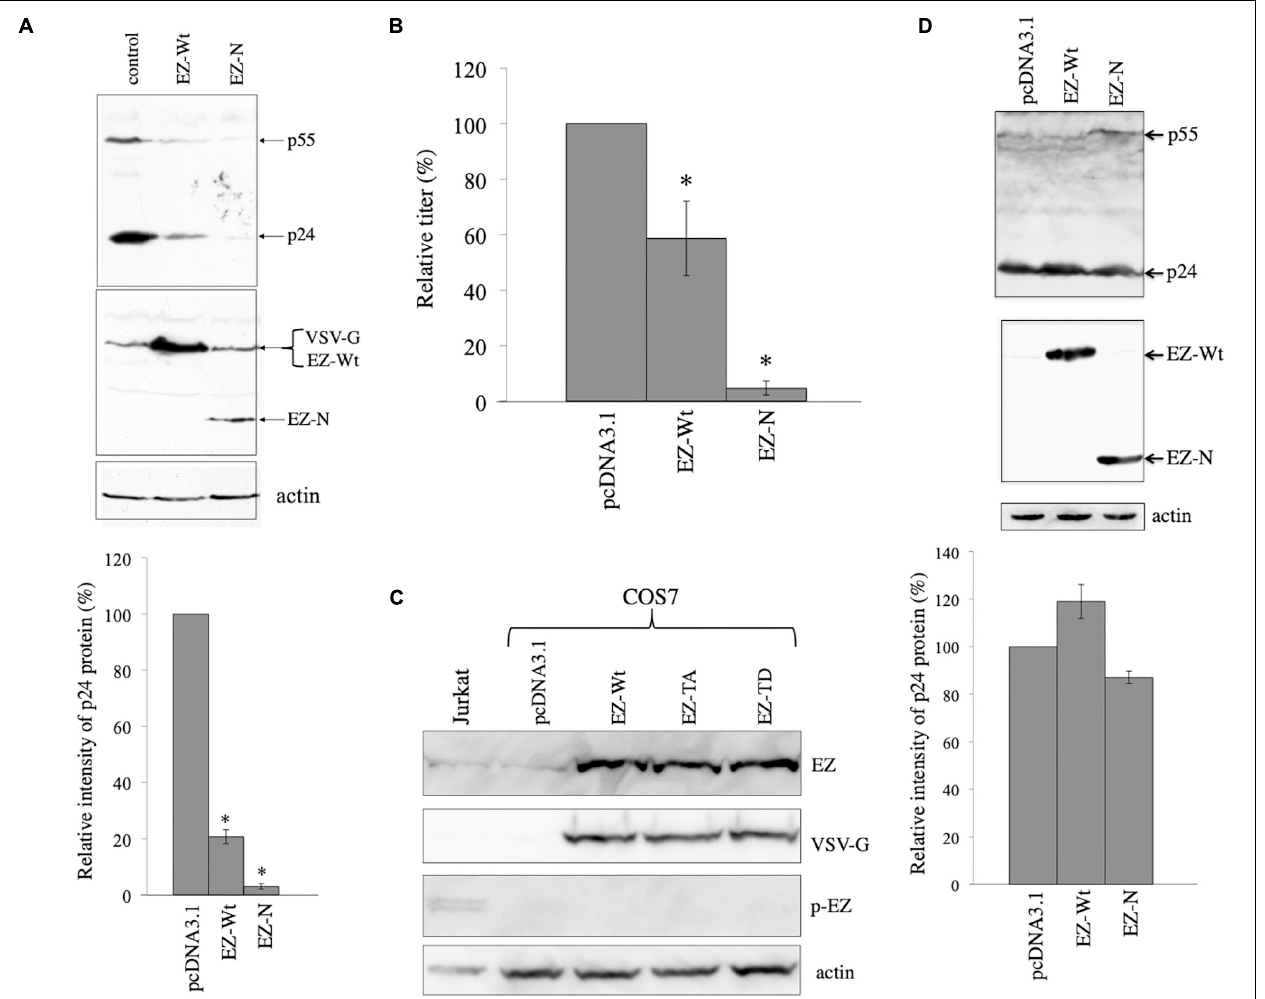
FIGURE 4 | Ezrin is involved in the VSV-G-mediated stabilization of HIV-1 Gag protein. (A) COS7 cells were transfected with the VSV-G-pseudotyped HIV-1 vector construction plasmids together with pcDNA3.1 (control), VSV-G-tagged ezrin wild type (EZ-Wt), or VSV-G-tagged ezrin dominant negative mutant (EZ-N) expression plasmid. Cell lysates from the transfected cells were analyzed by western immunoblotting (upper panel). HIV-1 Gag precursor (p55), mature capsid (p24), EZ-Wt, EZ-N, and VSV-G proteins were indicated by arrows. Ez-Wt and VSV-G were not separated. Intensities of the HIV-1 p24 protein bands were measured by a densitometer. Relative values to the intensities in the pcDNA3.1-transfected cells are indicated (lower panel, n = 3). Asterisks show significant differences compared to pcDNA3.1. (B) Culture supernatants from the transfected cells were inoculated into HeLa cells, and transduction titers were counted. Transduction titers in the pcDNA3.1-transfected cells were always set to 100. Relative values to the titers in the pcDNA3.1-transfected cells are indicated. This experiment was repeated three times, and means ± standard deviations are indicated. Asterisks show significant differences compared to pcDNA3.1. (C) COS7 cells were transfected with pcDNA3.1, EZ-Wt, EZ-TA, or EZ-TD expression plasmid. Cell lysates from the transfected COS7 and Jurkat cells were analyzed by western blotting using the indicated antibodies. (D) COS7 cells were transfected with the HXB2 Env-containing HIV-1 vector construction plasmids together with pcDNA3.1, EZ-Wt, or EZ-N expression plasmid. Cell lysates from the transfected cells were analyzed by western immunoblotting (upper panel). Intensities of p24 protein bands were measured. Relative values to the intensities in the pcDNA3.1-transfected cells are shown (lower panel, n = 3).